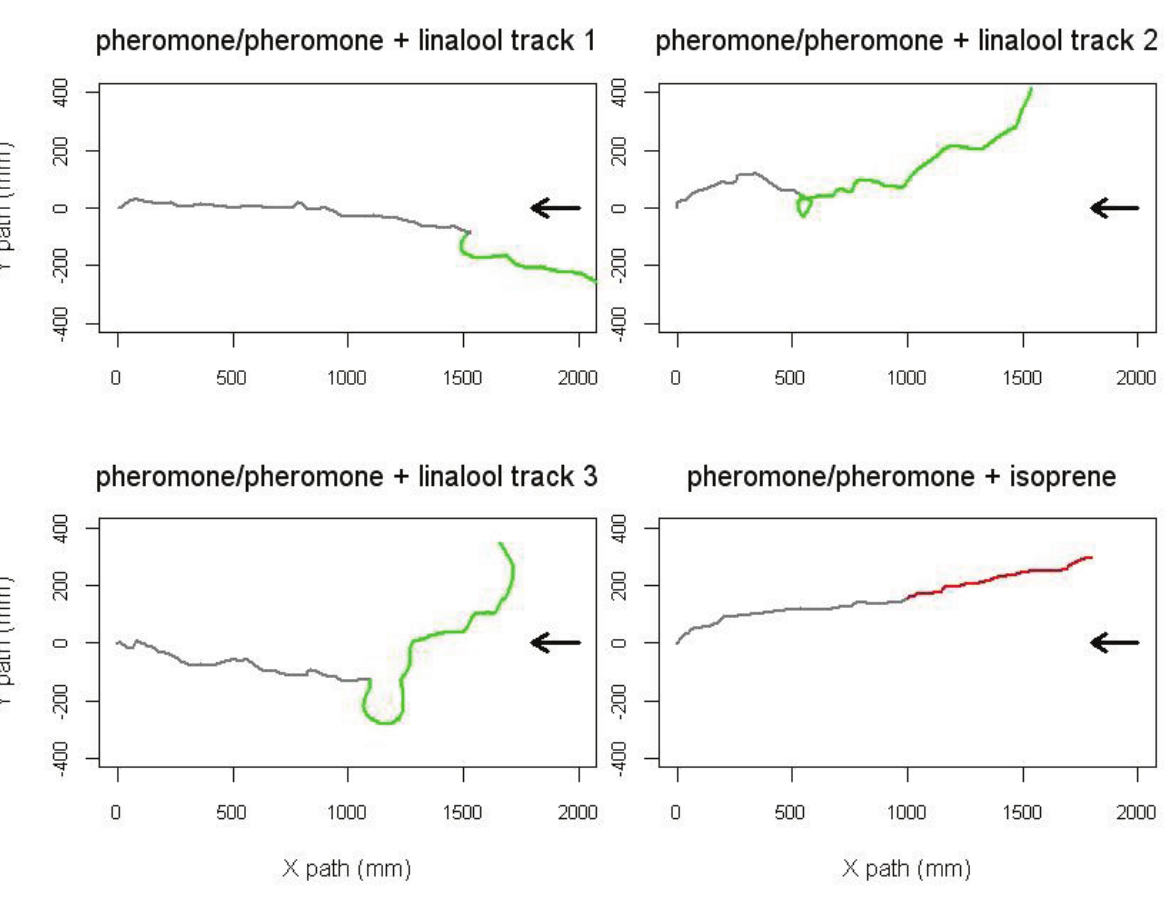
Figure 5. A change of odorant background modifies the orientation behavior of Spodoptera littoralis males towards their pheromone. Samples of 2-dimensional walking tracks were recorded with a locomotion compensator. Individual males were stimulated with the main pheromone component, Z9E11-14:Ac, for 2 min and their walking track was recorded showing active upwind walking activity (grey tracks). After 1 min, a plant volatile compound (linalool) was added to the pheromone carrying airflow (green track). Males showed a transitory change in their direction and speed at linalool onset (three examples). In turn, isoprene (red track) did not modify their walking activity. The black arrows indicate the direction of the airflow. Data are redrawn from